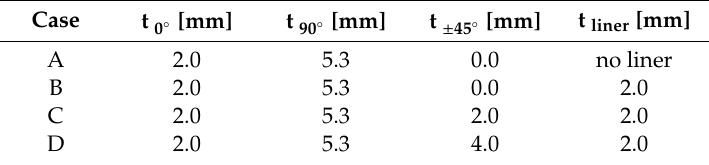
Table 7. The thickness of plies and of the inner liner subdivided by orientation angle φ , adopted for the test cases studied for the composite cylinder